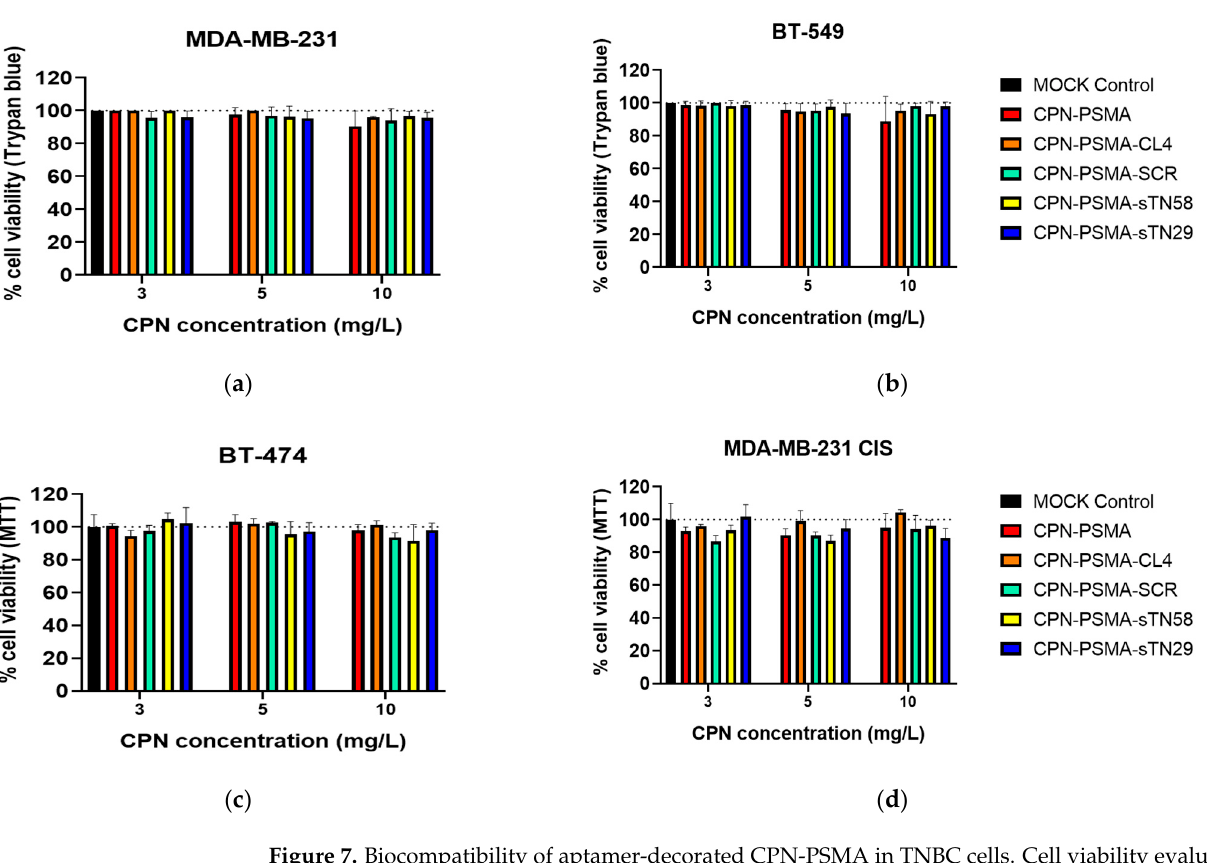
Figure 7. Biocompatibility of aptamer-decorated CPN-PSMA in TNBC cells. Cell viability evaluated by Trypan blue exclusion assay after 24 h incubation time of TNBC MDA-MB-231 ( a ) and BT-549 ( b ) with increased concentration of aptamer-decorated CPNs. Cell viability evaluated by MTT assay after 24 h incubation time of non-TNBC BT-474 ( c ) and TNBC MDA-MB-231/cis ( d ) with increased concentration of aptamer-decorated CPNs.